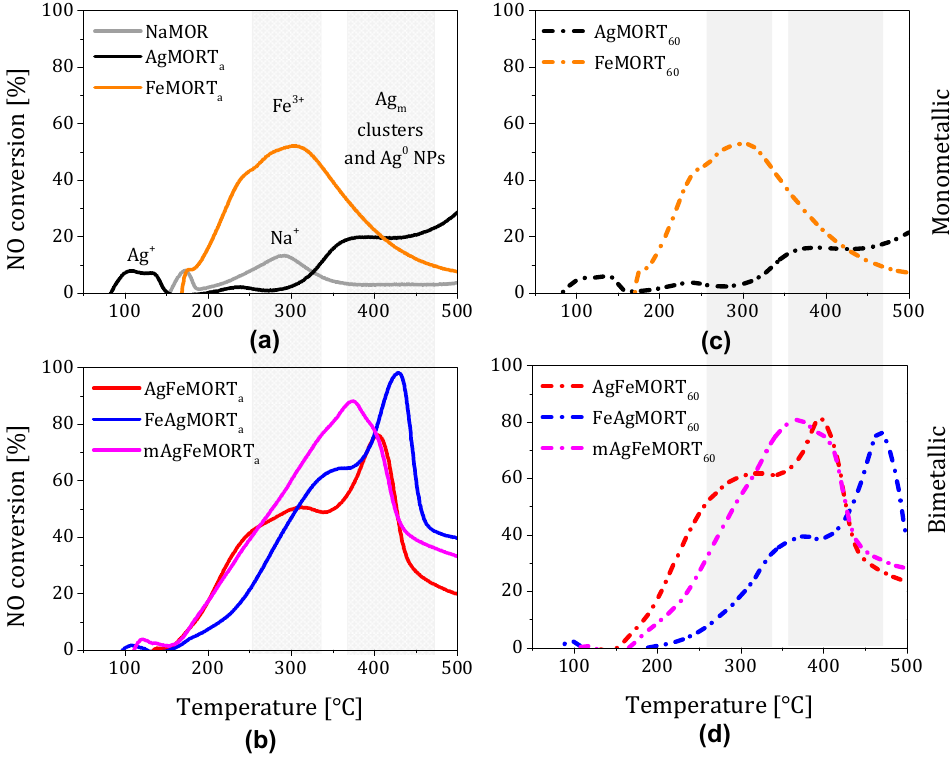
Figure 5. Catalytic performance of NaMOR, Ag or Fe monometallic, and Ag-Fe bimetallic catalysts prepared at room temperature ( a , b ) and 60 °C ( c , d ) for NO reduction as a function of reaction temperature. Reaction conditions: NO (850 ppm), C 3 H 6 (350 ppm), O 2 (2.1 vol %), CO (0.4 vol %), and N 2 balance, flow rate 78 mL·min − 1 and GHSV (15,000 h − 1 ).